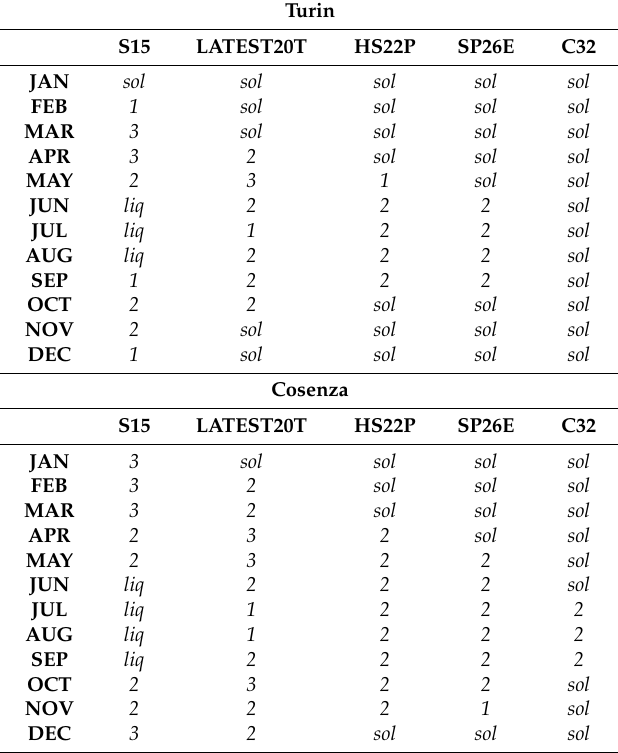
Table 2. Number ( 1 , 2 , 3 ) of bi-phase interfaces present in the layer in the different months of the year in Cosenza and Turin for the different PCMs. sol the entire layer is in solid phase, liq the entire layer is in liquid